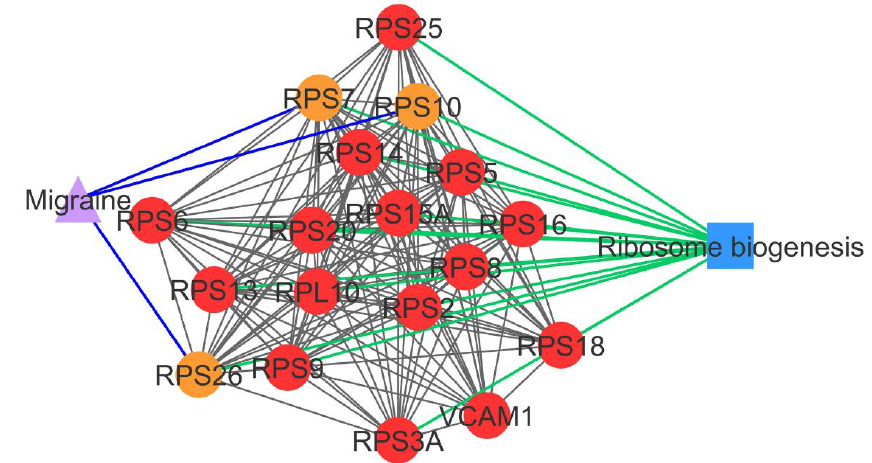
Figure 2. PCOS–disease subnetwork 1. This subnetwork highlights shared proteins and one shared pathway (ribosome biogenesis) between PCOS and migraine. Different coloring of nodes and lines represents PCOS-related proteins (red), shared proteins (orange), PCOS–disease interactions (blue), and protein–pathway interactions (green). Circle nodes refer to PCOS-related proteins, triangle nodes refer to disease, and square nodes refer to pathway.